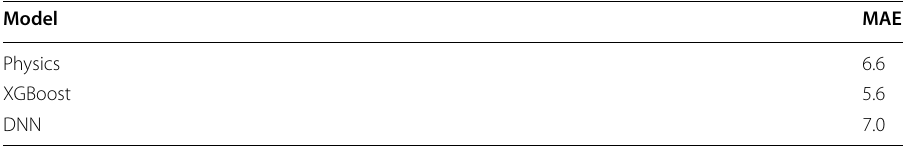
Table 6 Average mean absolute errors and standard deviations (with unit of XGBoost and DNN model predictions compared to the measured temperature data